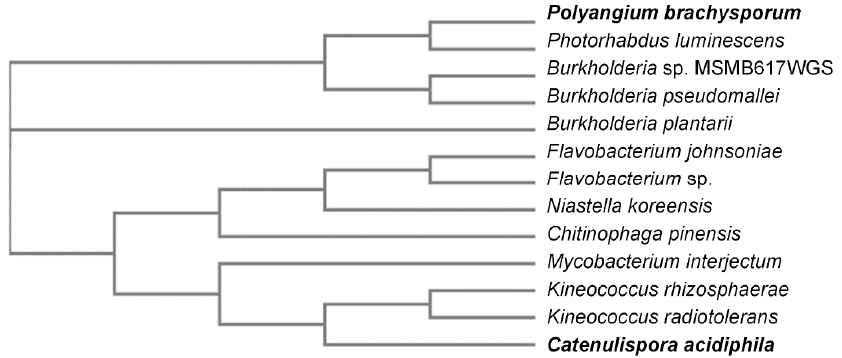
Figure 2. Phylogenetic tree of the organisms of origin of the known and putative KDOs considered in this study. The figure was created using the EMBL-EBI Web Service [20] with the respective protein sequences.